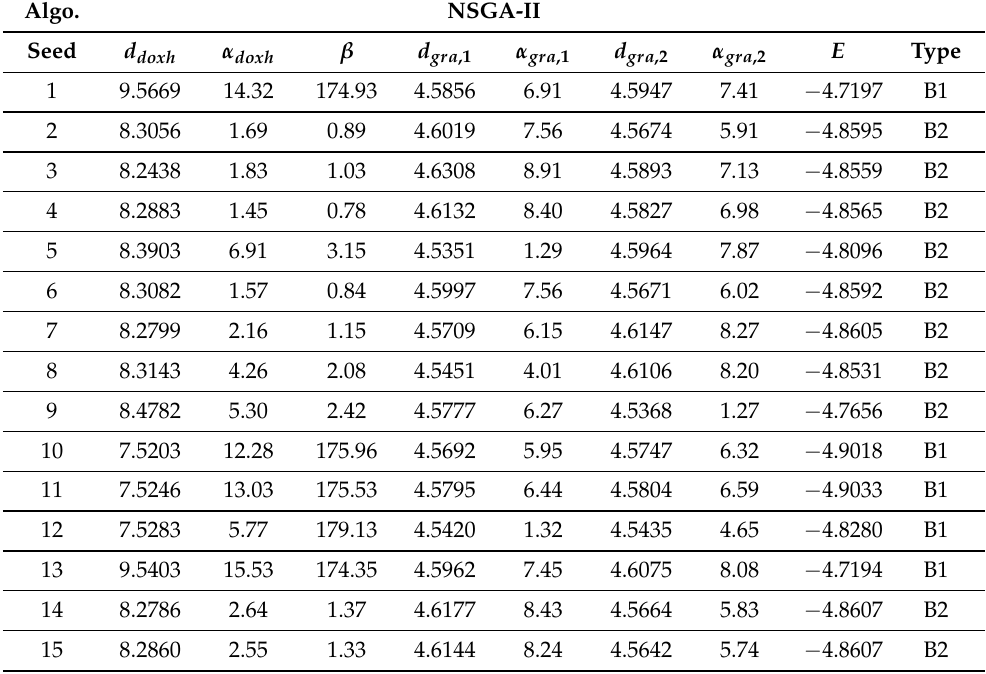
Table 5. Numerical results of d doxh (Å), d gra ,1 (Å), d gra ,2 (Å), α doxh (degrees), α gra ,1 (degrees), α gra ,2 (degrees), β (degrees) and E (eV) for two DOXHs interacting with graphene. Algo.